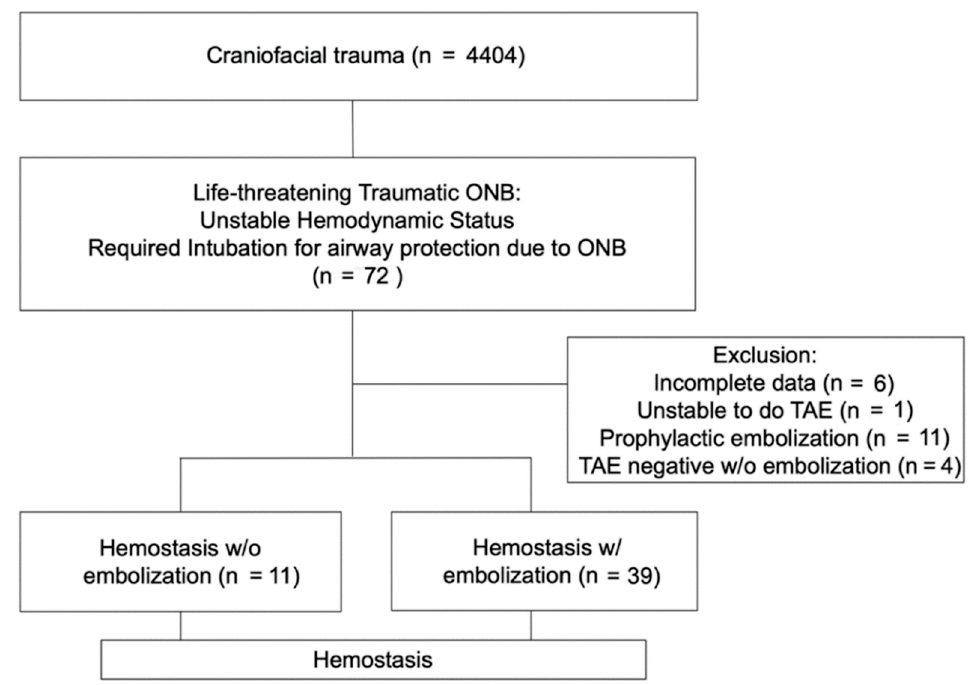
Figure 1. The flowchart of patients who met inclusion/exclusion criteria of this study. We compared two group of patients. The first group consisted of patients who did not require TAE for hemostasis (non-TAE group) and the second group consisted of patients requiring TAE for hemostasis (TAE group). The medical records were independently